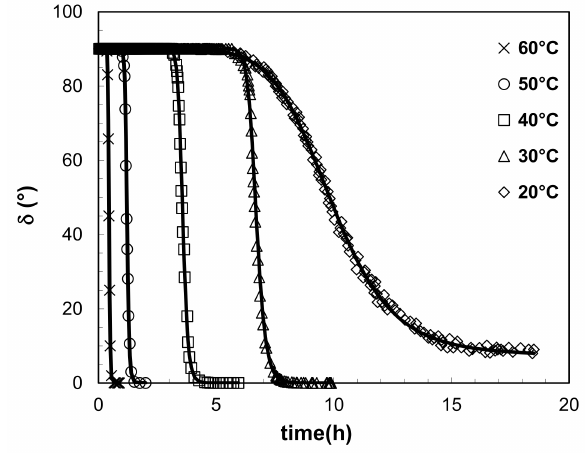
Figure 8. Changing of phase angle d with time of gelation process at different temperatures. Depen- dence of dynamic moduli G (cid:48) and G (cid:48)(cid:48) on time of the WO 3 gelation at different temperatures.